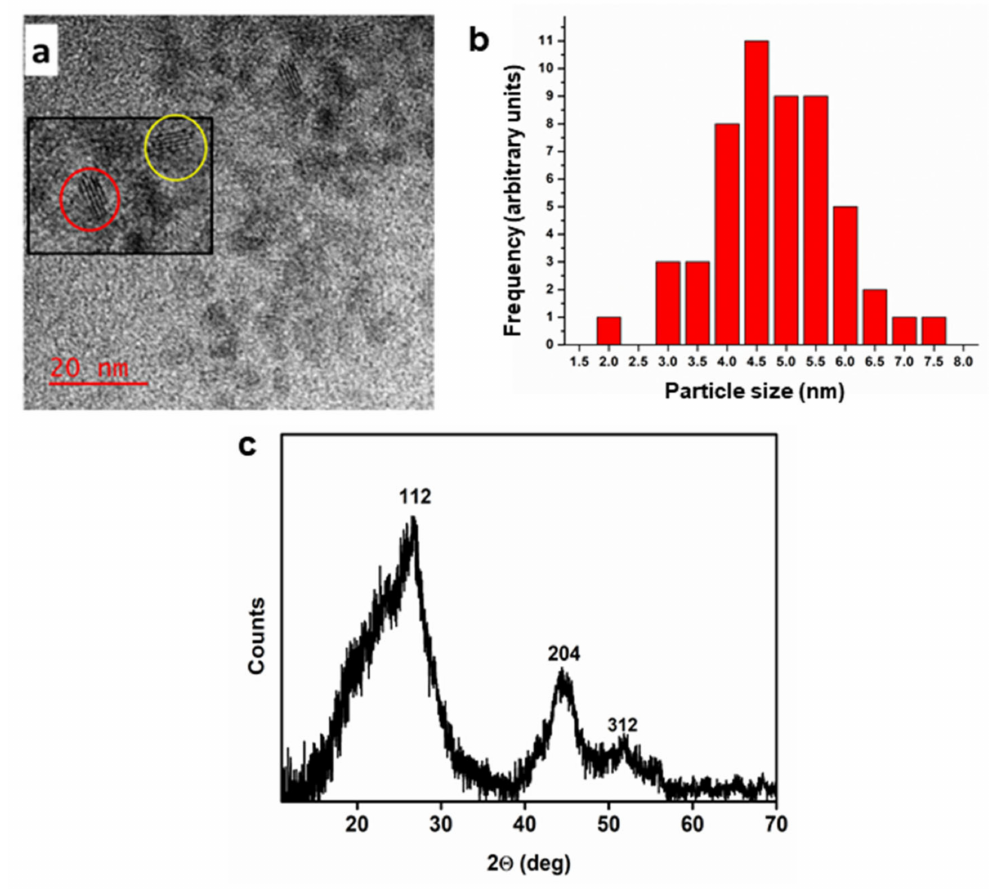
Figure 1. ( a ) TEM micrograph, and ( b ) particle size distribution ( c ) XRD of the as synthesized AgInSe/ZnS